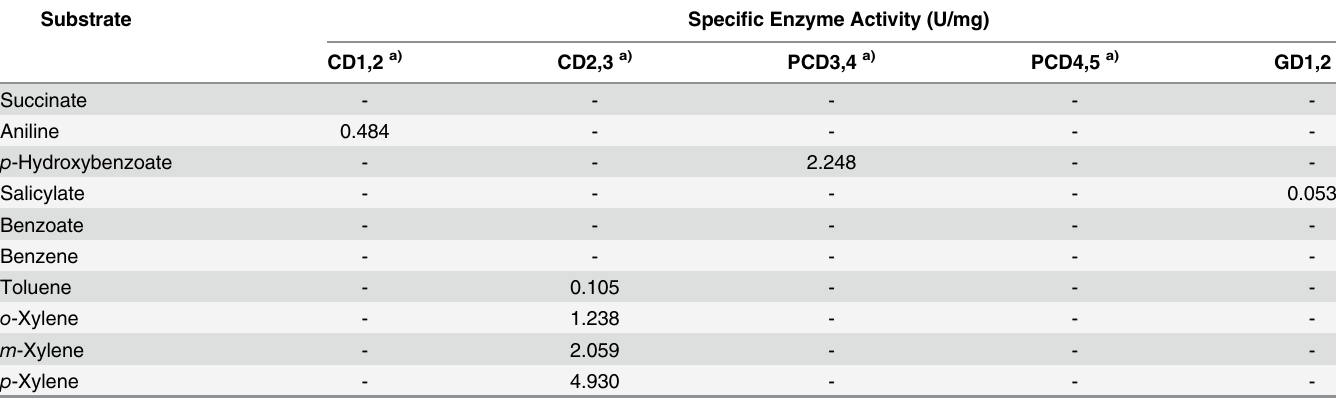
Table 1. Dioxygenase activities of Burkholderia sp. K24 for monocyclic aromatic compounds.